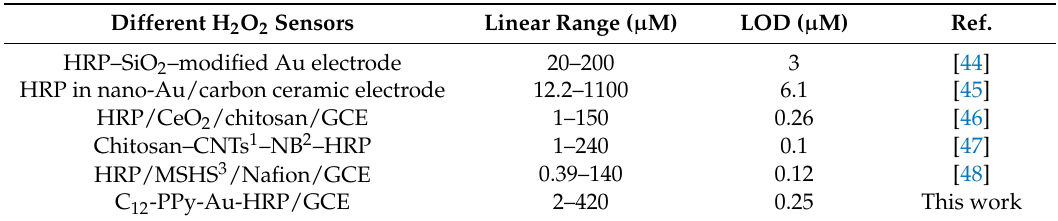
Table 1. Comparison of detecting performance of C 12 -PPy-Au-HRP/GCE biosensor with that of some other HRP-based H 2 O 2